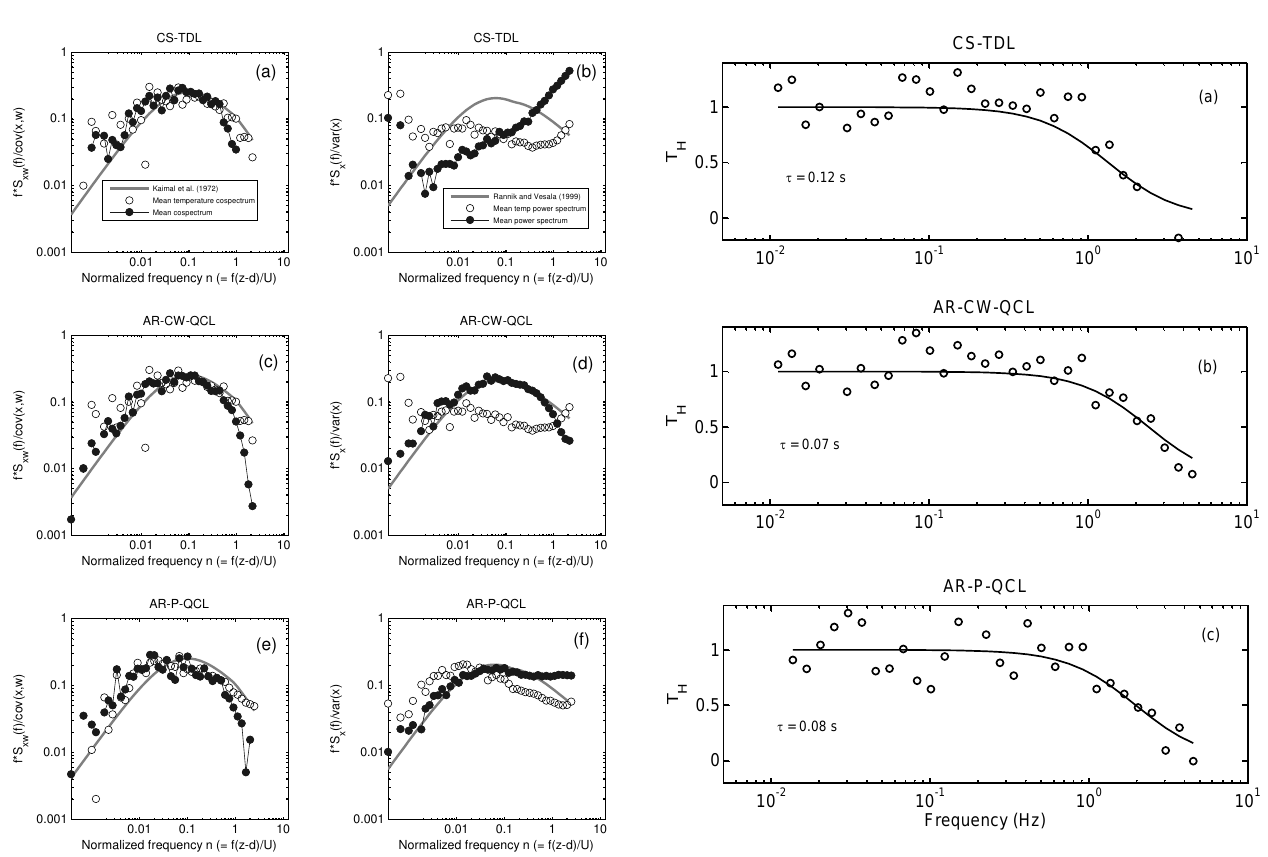
Figure 3. Normalized co-spectra (left panels) and spectra (right panels) of N 2 O measurements by instruments CS-TDL (a, b) , AR- CW-QCL (c, d) and AR-P-QCL (e, f) during the high flux period, DOY 146 (26 May 2011) 7:00 to 13:00EET. The RCG crop was about 0.4m tall during the given period.